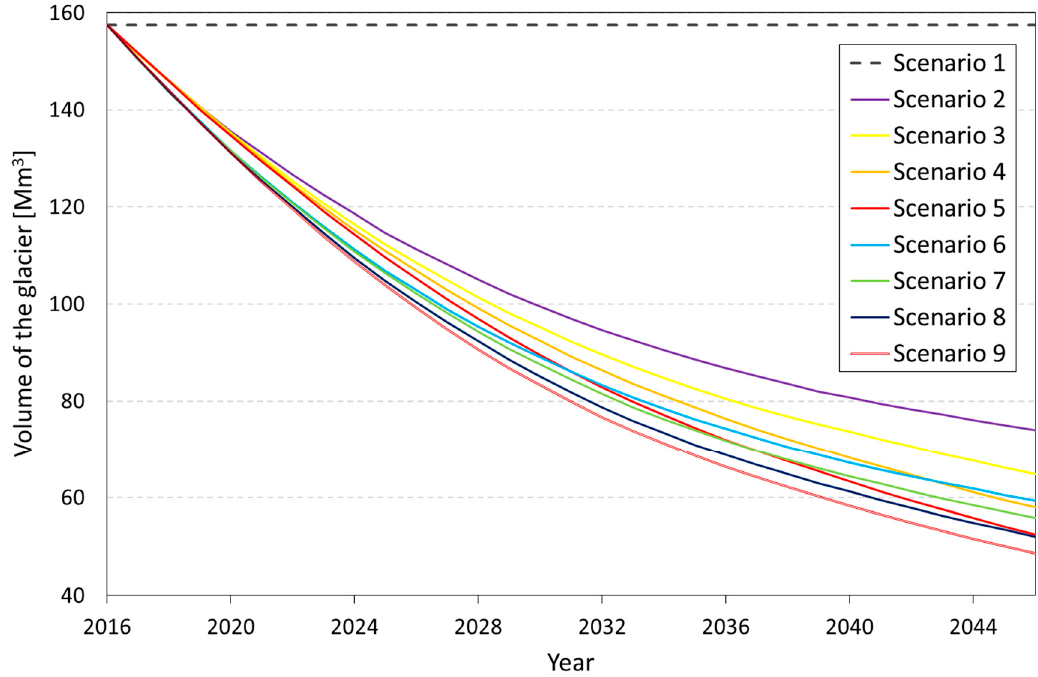
Figure 5. Evolution of glacier’s volume in the years of simulation.